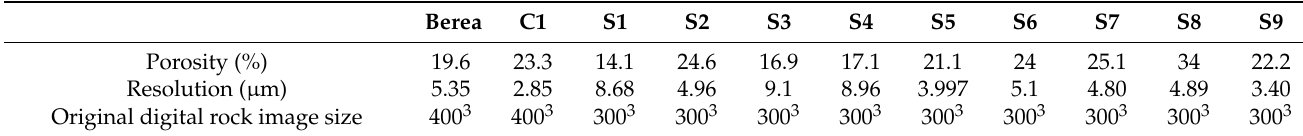
Table 1. Porosity and resolution of the digital rock images and original digital rock image size used for flow simulation.